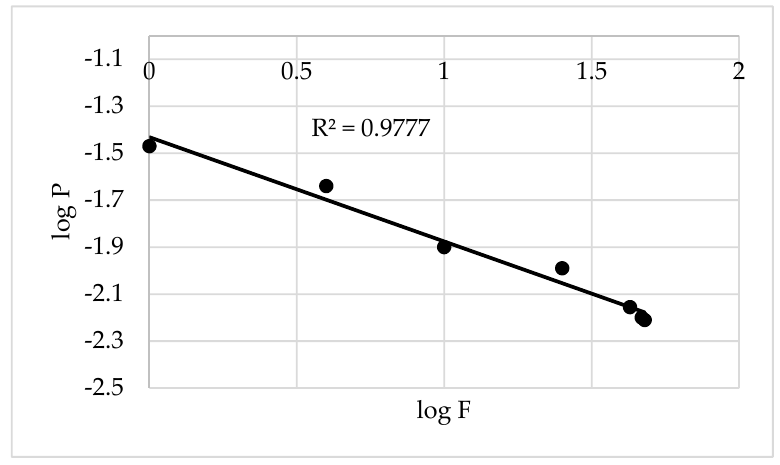
Figure 2. Linearized dependence of P on F in double logarithmic coordinates.